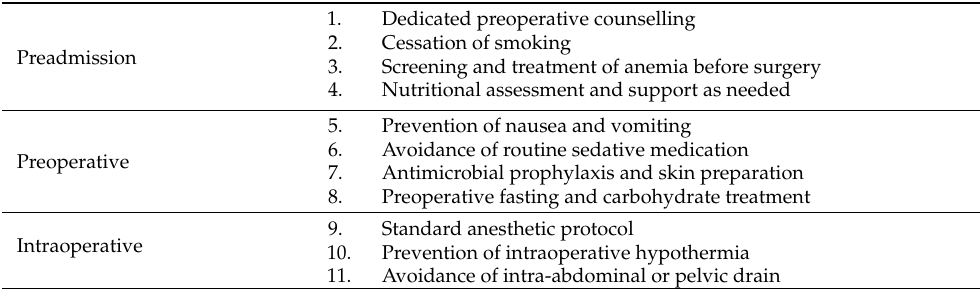
Table 1. Tailored ERAS